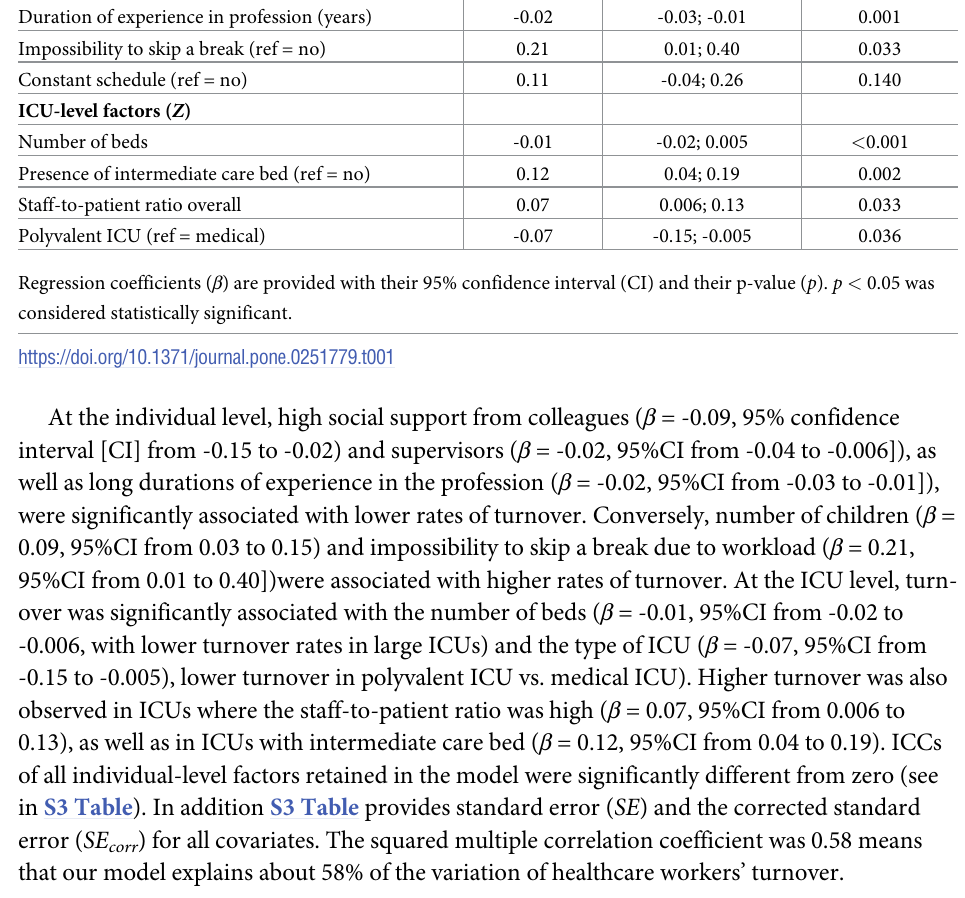
Table 1. Results of the adjusted regression analyses of turnover on individual- and ICU-level factors.